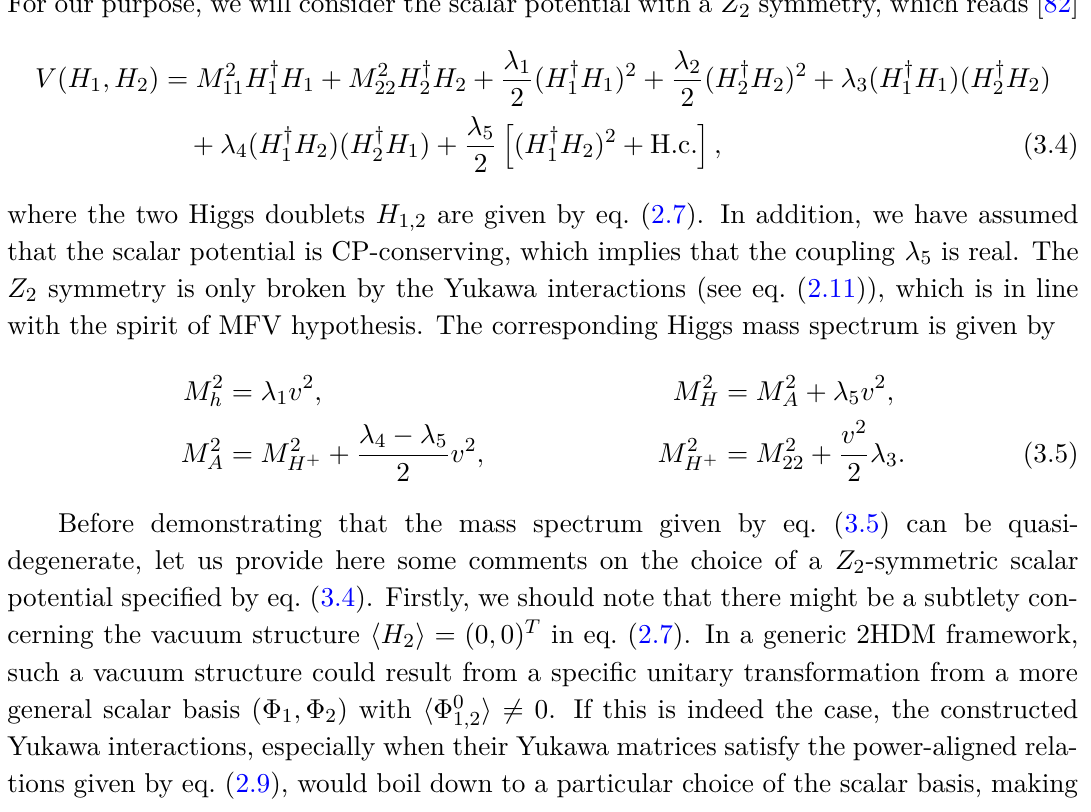
Figure 1 . Lower bounds on the charged-Higgs mass M and the mass differences ∆ M d,s . Here the 2 σ ranges of the ratios ∆ M exp updated ∆ M SM from refs. [52, 53], are used as d,s